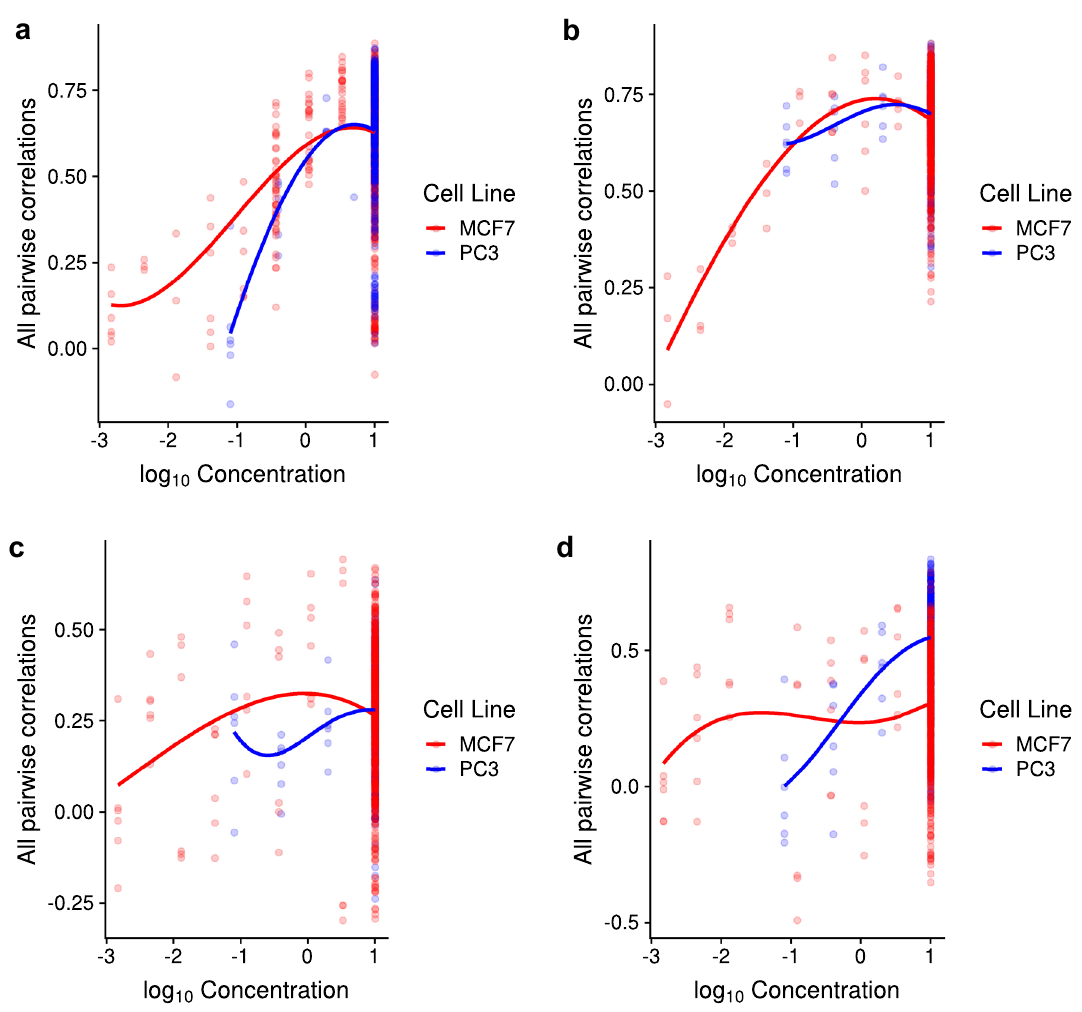
Figure 4. Scatter-plot of all pairwise rank correlations of DE profiles against compound concentration, for four different compounds (vorinostat, trichostatin A, geldanamycin and wortmannin for panels ( a – d ) respectively). Underlying data used is CMap 2-MZS and all genes were used in the calculations. Lines are LOESS fit of the correlations, while colours distinguish the cell lines being